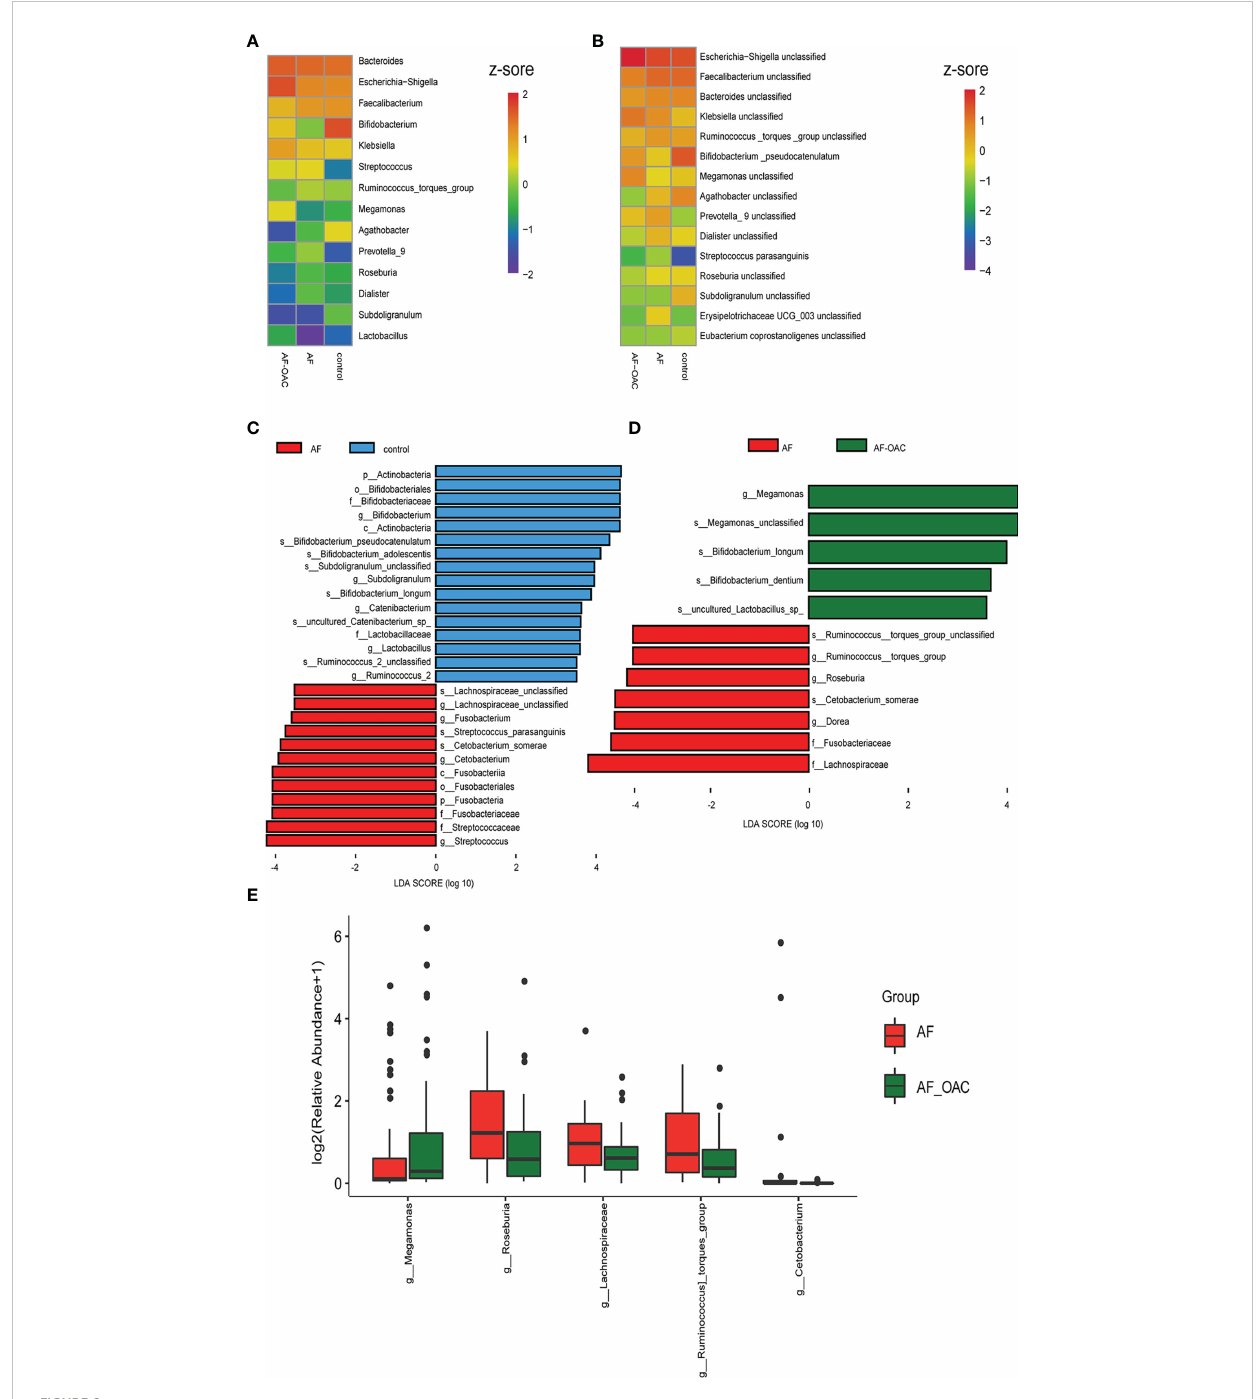
FIGURE 2 Common taxa and biomarkers in the three groups. (A) Heat map of the top 15 shared genera. Abundance pro fi les transformed Z-scores via average abundance subtraction and division by the standard deviation. Negative (blue) and positive (red) Z-scores revealed that the row abundance levels were lower and higher compared with the mean. (B) Heat map of the fi rst top 15 shared species. The abundance pro fi les were analyzed as in A. (C) Taxonomic cladogram obtained using linear discriminant analysis (LDA) effect size (LEfSe) analysis and Wilcoxon test of the 16SrRNA gene sequences. LEfSe analysis identi fi ed the taxa with the largest differences in abundance between the AF and control groups. (D) Largest difference in taxa between the AF and AF-OAC groups obtained by LEfSe analysis. (E) Differences in the relative abundance of intestine microbiota between AF and AF-OAC groups at the genus level (Mann – Whitney U